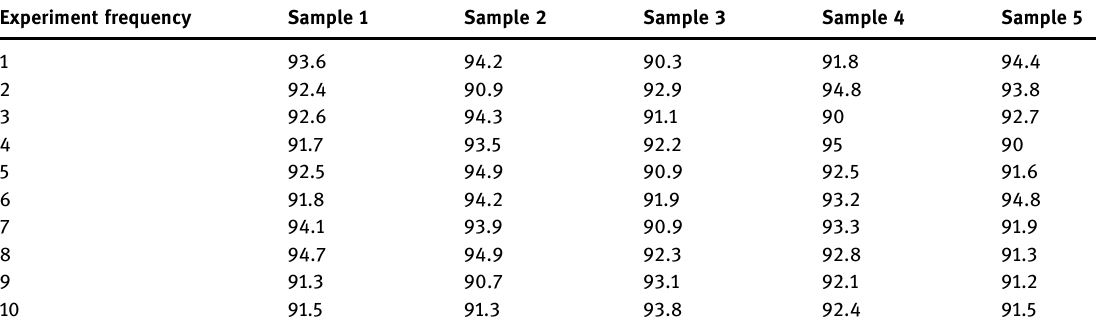
Table 4: Image reconstruction completeness of the method in ref. [ 5 ] ( % )